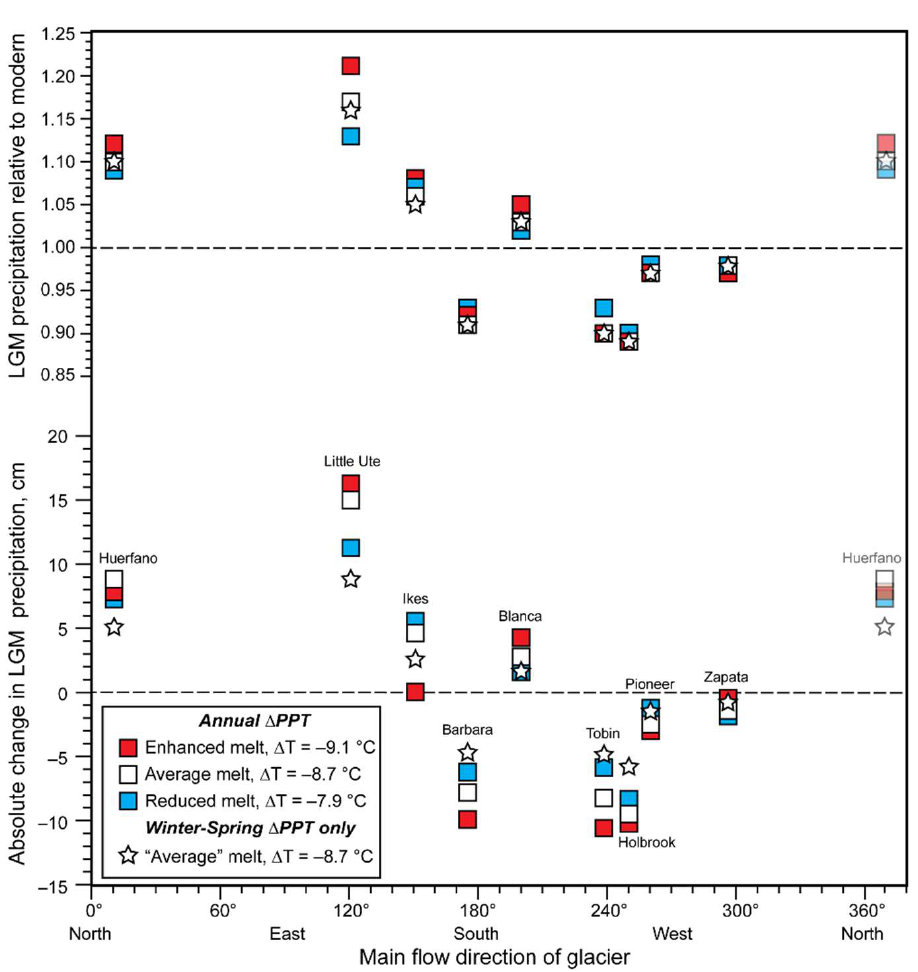
Figure 9. Changes in LGM mean annual and winter–spring precipitation required to maintain steady-state mass balances under the assumptions of regionally uniform temperature depressions corresponding to average, enhanced, and reduced melt scenarios. Note values for Huerfano glacier are included twice in order to help visualize direction dependence.